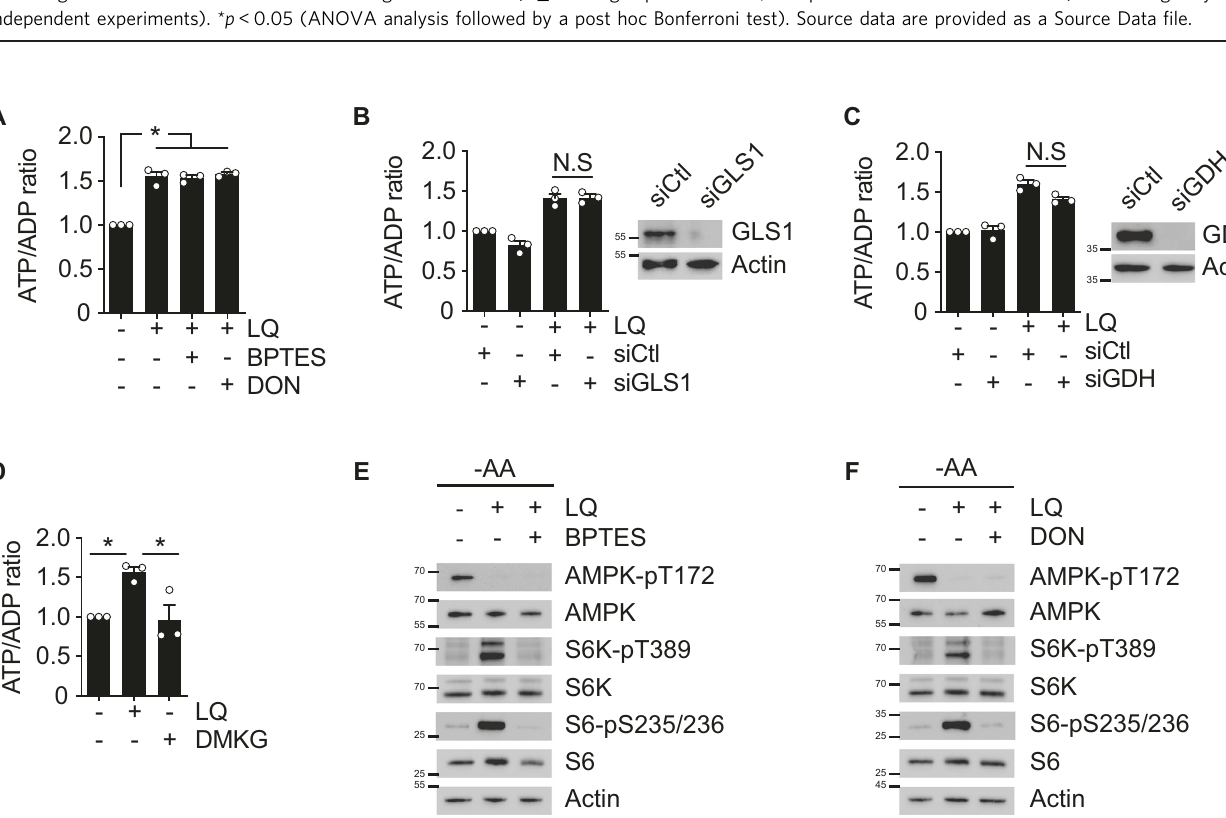
Fig. 3 Glutamine is suf fi cient to sustain ATP levels, but not to activate mTORC1. A ATP/ADP ratio of amino acid-starved U2OS cells incubated in the presence or absence of LQ with or without BPTES or DON during 72 h. B , C GLS or GDH expressions were knocked down using small interfering RNA (siRNA) in U2OS cells for 48 h. Cells were then treated with LQ for 72 h and the ATP/ADP ratio was measured. Scramble non-targeting siRNA was used as a control. Immunoblots of GLS or GDH levels are presented as a control of the knockdown. D ATP/ADP ratio of amino acid-starved U2OS cells treated with LQ or DMKG for 72 h. E , F Immunoblot of amino acid-starved U2OS cells treated with or without LQ in combination with BPTES ( E ) or DON ( F ) for 72 h. Activity markers of AMPK and mTORC1 were analysed. Graphs show mean values ± SEM ( n = 3 biologically independent experiments). * p < 0.05